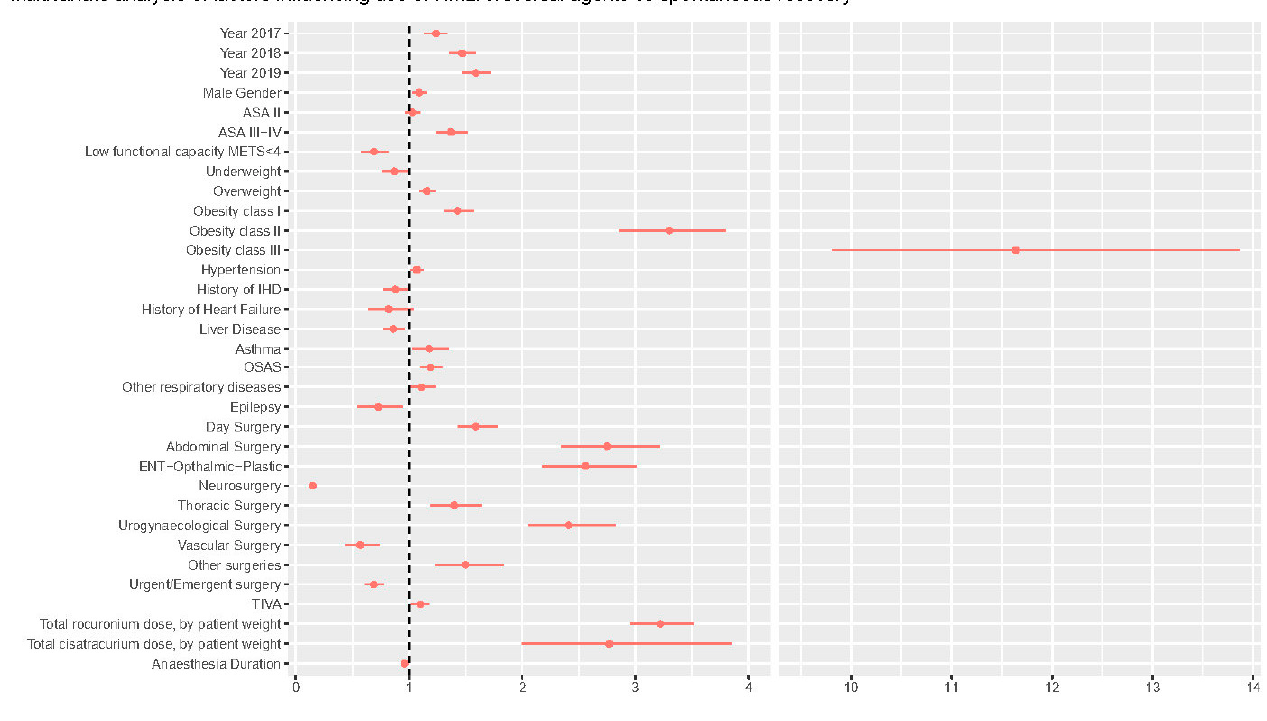
Figure 2. Time trends in NMBA reversal practice.